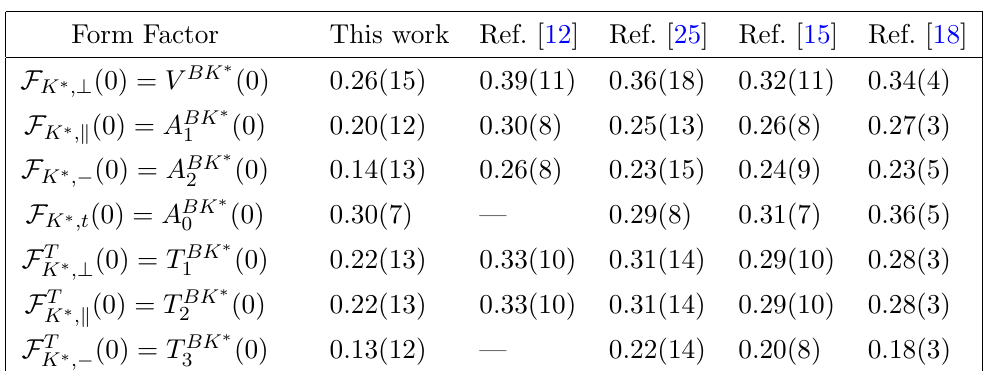
Table 6 . Results for the form factors at q 2 = 0 in the narrow-width limit,compared to corresponding results in the literature. The approach in ref. [18] is a completely di(cid:11)erent LCSR approach, in terms of K (cid:3) DAs.